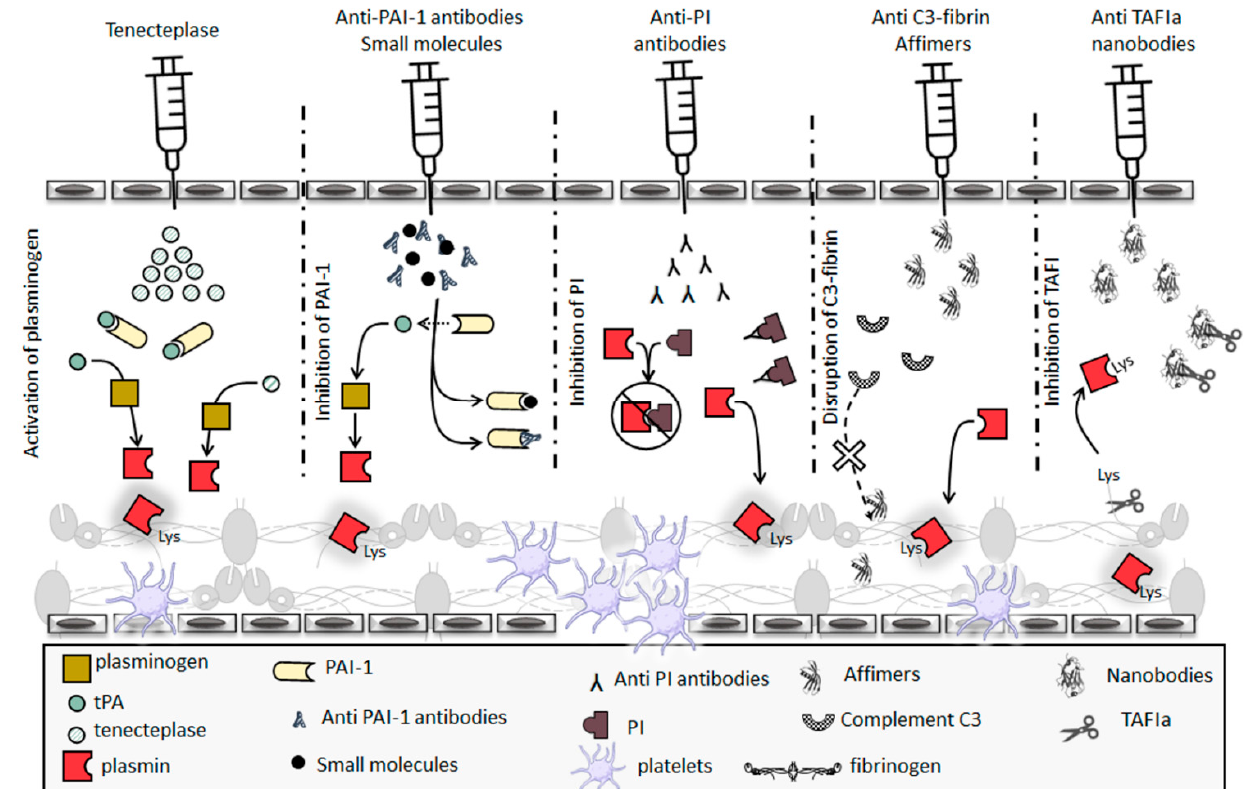
Figure 4. Current and potential thrombolytic therapies. The aim of thrombolytic drugs is to breakdown obstructive clots. Tenecteplase is a third-generation thrombolytic drug that has high specificity for fibrin and is available for clinical use. Due to complexities associated with use of tenecteplase, TAFI, PAI-1, PI and C3 are being explored as therapeutic targets. Small molecule and antibodies have been developed to inhibit PAI-1, which should enable more efficient plasminogen to plasmin conversion. Anti-PI antibodies interact with PI preventing its ability to block plasmin activity, thus enhancing clot lysis. C3 has been shown to interact with fibrin enhancing clot resistance to lysis, an effect that can be modulated with the use of Affimer technology. A panel of nanobodies has been found that inhibit TAFIa activation and activity, consequently facilitating lysis. While PAI-1, PI, C3 and TAFI- targeted therapies are exciting and offer a specific approach, none of these inhibitory agents made into clinical practice and future research in this area is